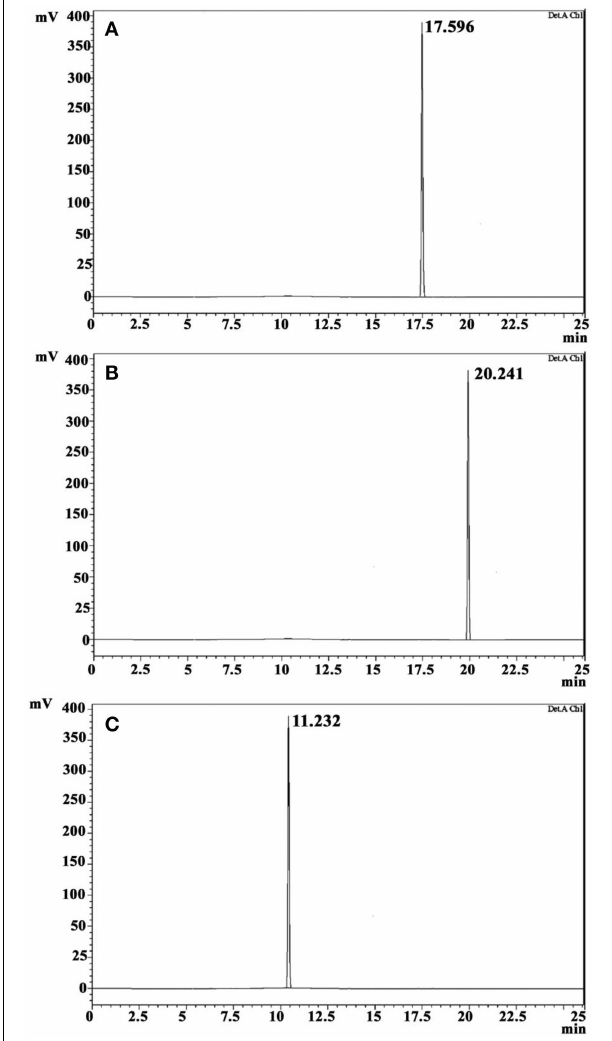
FIGURE 2 | HPLC profile of CDPs on a reversed-phase C18 HPLC column. Cyclo(D-Leu-D-Arg) (A) , Cyclo(L-Trp-L-Arg) (B) , and Cyclo(D-Trp-D-Arg) (C)